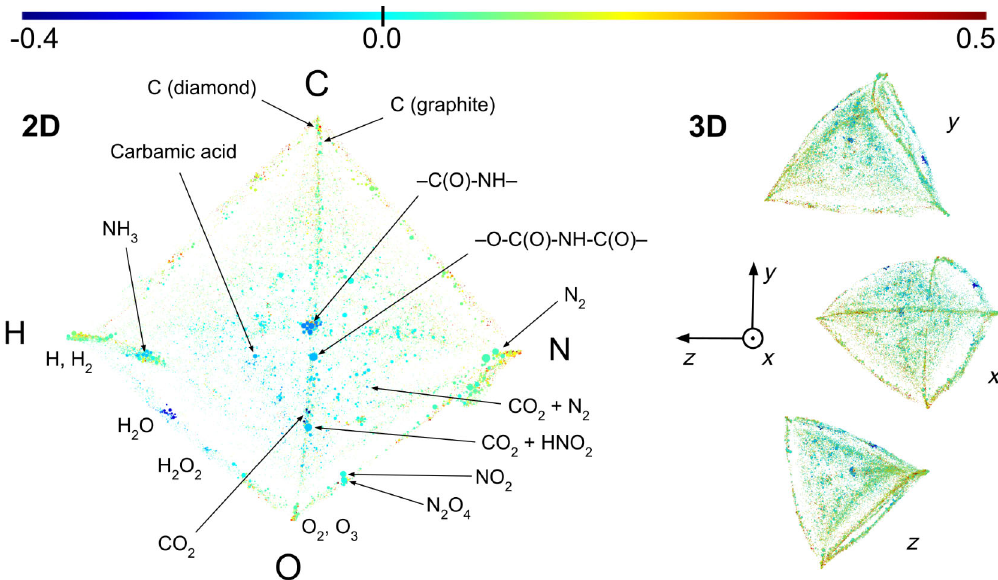
FIG. 12. 2D and 3D SHEAP maps for 21239 structures containing carbon, hydrogen, nitrogen, and oxygen at varying stoichiometries, obtained with AIRSS performed at 1 GPa, taken from the Materials Cloud Archive [77]. Structures in the source data are represented as concatenated global SOAP vectors using smart universal parameters: r Projections use a perplexity of 30, with R 0 computed by Eq. (B1). Circles and spheres representing each structure are colored according to their formation energy per atom in eV; see the color bar at the top of the figure. Basin volumes are represented by the area (volume) of each circle (sphere). Each viewpoint of the 3D map looks down one of the axes displayed, as labeled; the axes have no other physical meaning. Regions containing polymorphs of various molecular species are labeled in the 2D